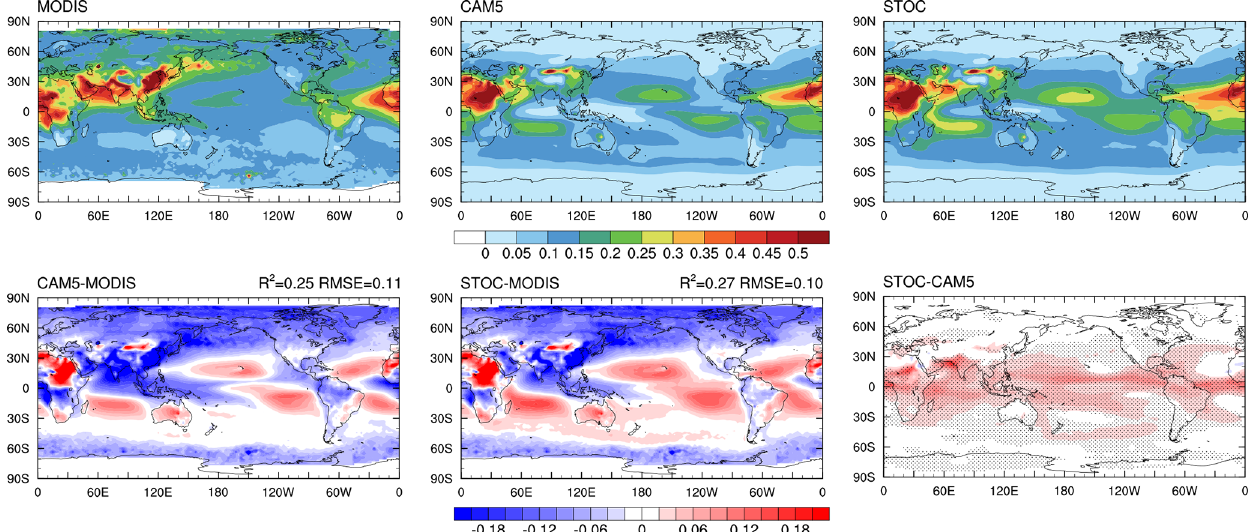
Figure 15. Global distributions of AOD in MODIS, CAM5 and STOC and their differences. The stippled areas indicate that the difference between CAM5 and STOC is statistically significant at the 0.05 level. Values in the top right corner for the differences between simulations and observations are the coefficient of determination ( R 2 ) and the weighted root-mean-square error